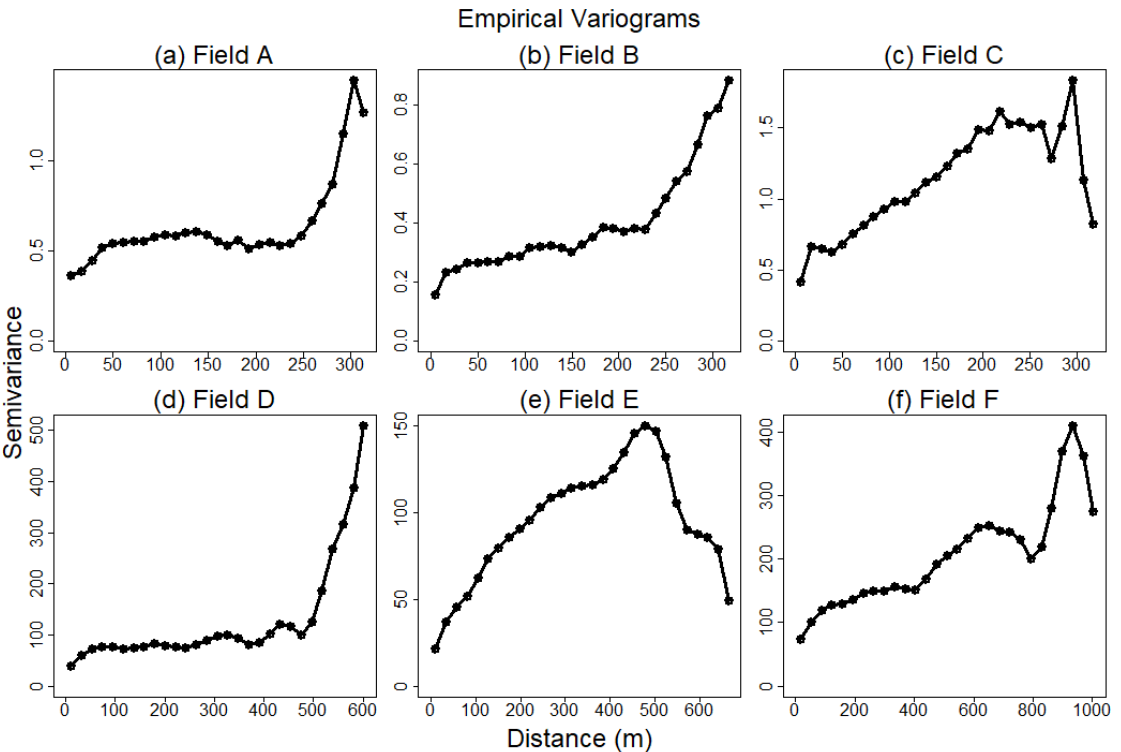
Figure 6. An empirical variogram for corn yield for six fields (Fields A–F) based on the yield estimates from the yield monitor and their corresponding spatial coordinates. Fields A, B, C ( a – c ) were harvested for grain. Fields D, E, F ( d – f ) were harvested for silage.